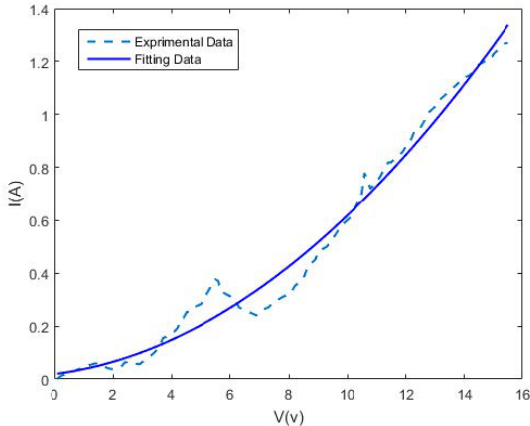
Figure A1. Characteristics of the CNP-based electro-thermal MSM with steel electrodes.